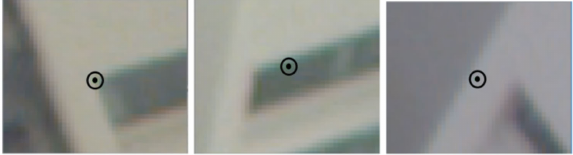
Figure 4. Left is the master image with the keypoint marked. Center and right are slave images with the intitial locations of the keypoint